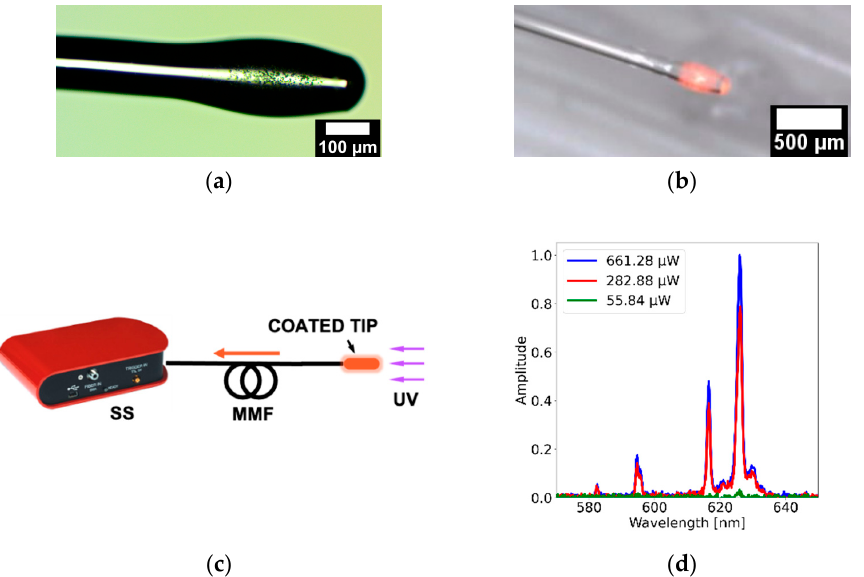
Figure 14. Multimode optical fiber coated with GOS:Eu: ( a ) microscopy image of the coated fiber; ( b ) coated tip showing the emission of the polymer coating; ( c ) setup used to obtain the fluorescence emission from the sensor tip as a function of optical power; ( d ) emission spectra obtained with irradiation from a UV light source (340 nm) using different powers (55.84 to 661.28 μ W).